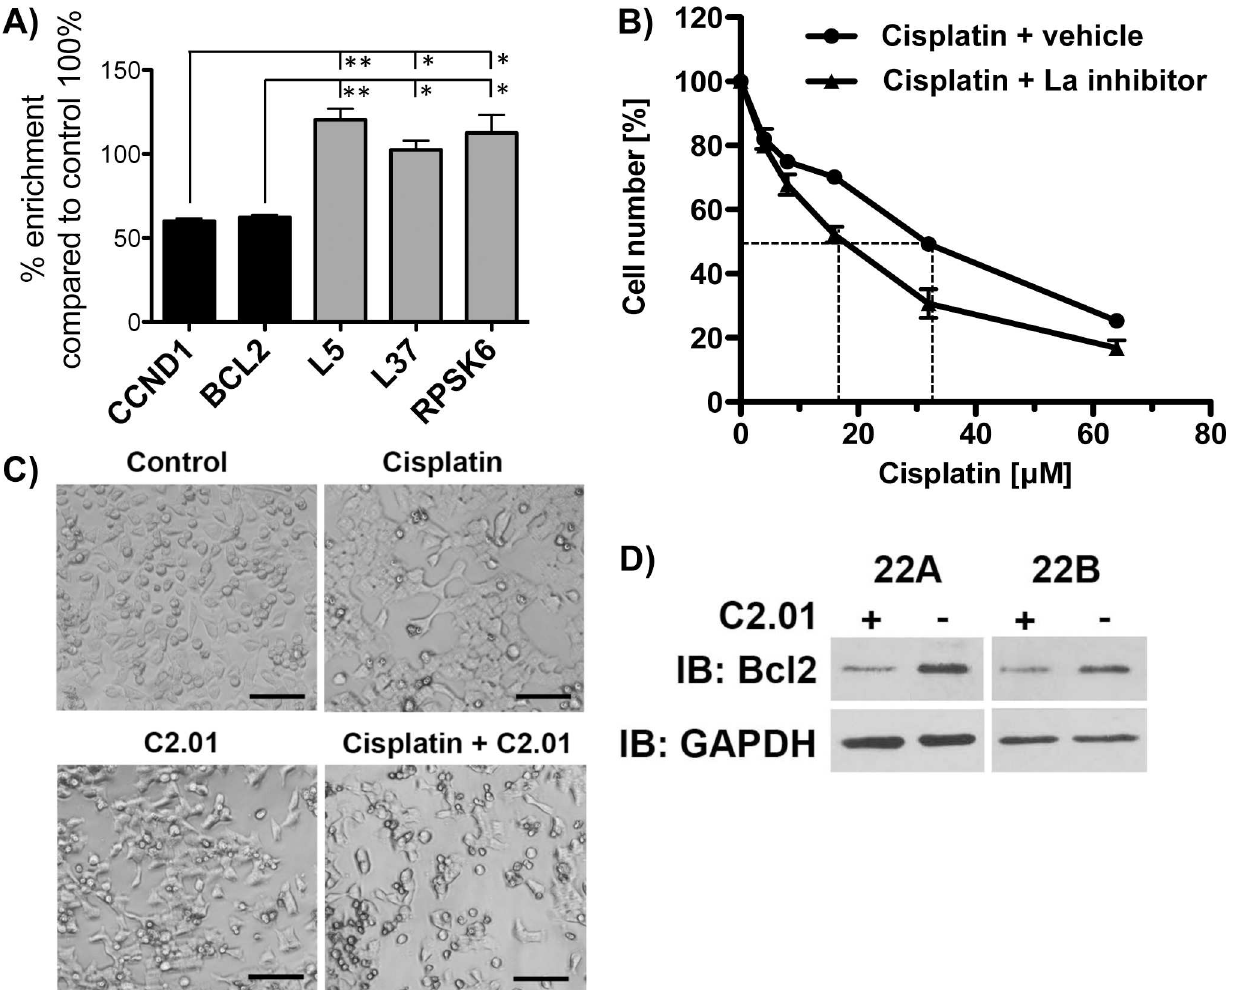
Fig 7. Compound C2.01 interferes with La:RNA binding in cells and sensitizes cells for cisplatin treatment. A) RNA Immunoprecipitation (RIP): RT-qPCR analysisof CCND1, Bcl2 andthree differentTOP mRNAs (L37, L5, RPSK6) associated with gfp-taggedLa-WT in HEK293 cells treated with or withoutC2.01 (150 μ M). The RNA bindingbetweenDMSO controland C2.01 treated cells was comparedusingthe formula: [C2.01 treated (RIP/input) / DMSO control (RIP/input)] X 100and the percentage of enrichment of mRNA in the control (DMSO treated) RIP pellet comparedto the input material was set as 100%. B) SCC 22B cells were treatedwith increasingconcentration of cisplatinand 50 μ M C2.01 for 48 hours. Cell numberswere quantifiedusingthe CyQuant kit. C) Comparingphasecontrast imagesof untreated SCC 22A cells, cells treated with cisplatin(at IC 50 = 12 μ M) or C2.01 (50 μ M) alone,or in combination, demonstrates a dramatically reducedcell numberin the co- treated sample. D) Immunoblot (IB) analysisfor anti-apoptotic factor Bcl2 in cisplatinalone or cisplatinand C2.01 co-treatedSCC 22A and SCC 22B cells. GAPDH serves as